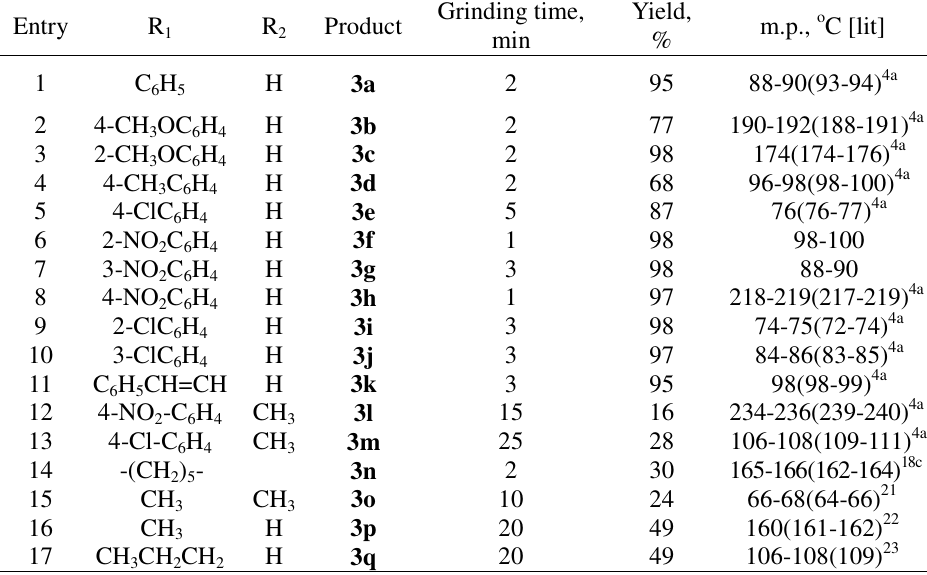
Table 2. Synthesis of di(indolyl)methanes from aldehydes (or ketones) and indole catalyzed by silicotungstic acid by